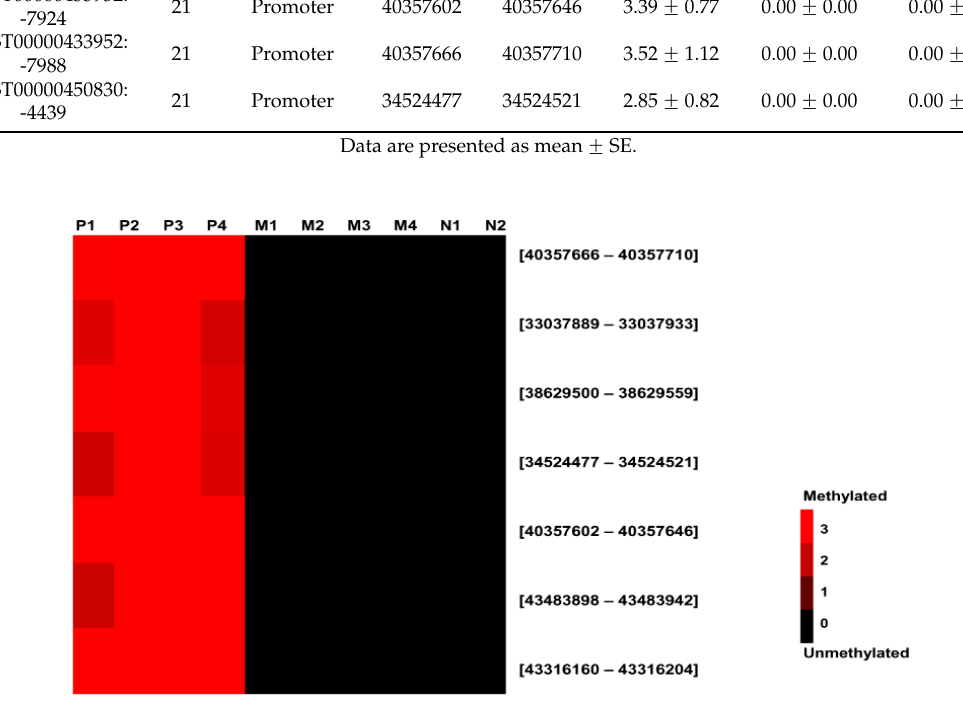
Figure 1. Methylation profiling of 7 identified regions in the subjects using the high-resolution tiling arrays. The red and black colors indicate high expression and non-expression, respectively. P, placenta; M, maternal blood cells; N, non-pregnant women blood